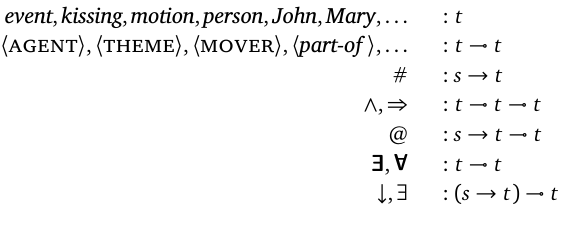
Constant terms of the semantic language